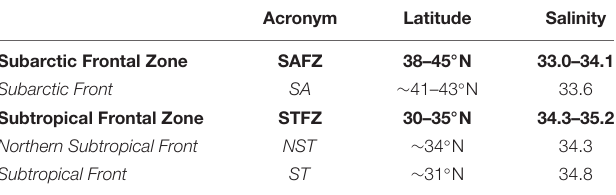
TABLE 1 | Frontal zones and fronts in the North Pacific transition